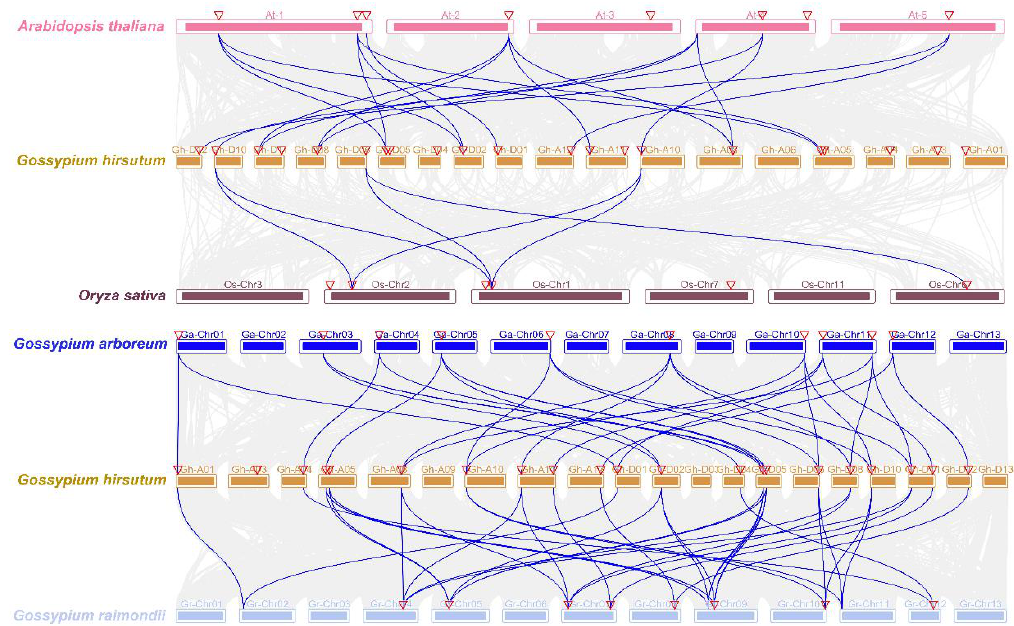
Figure 2. Collinearity analysis of BES1 gene in Arabidopsis, rice, and cotton and among three cotton varieties ( G. arboretum , G. raimondii , and G. hirsutum ). The triangle represents the location of the BES1 genes on the